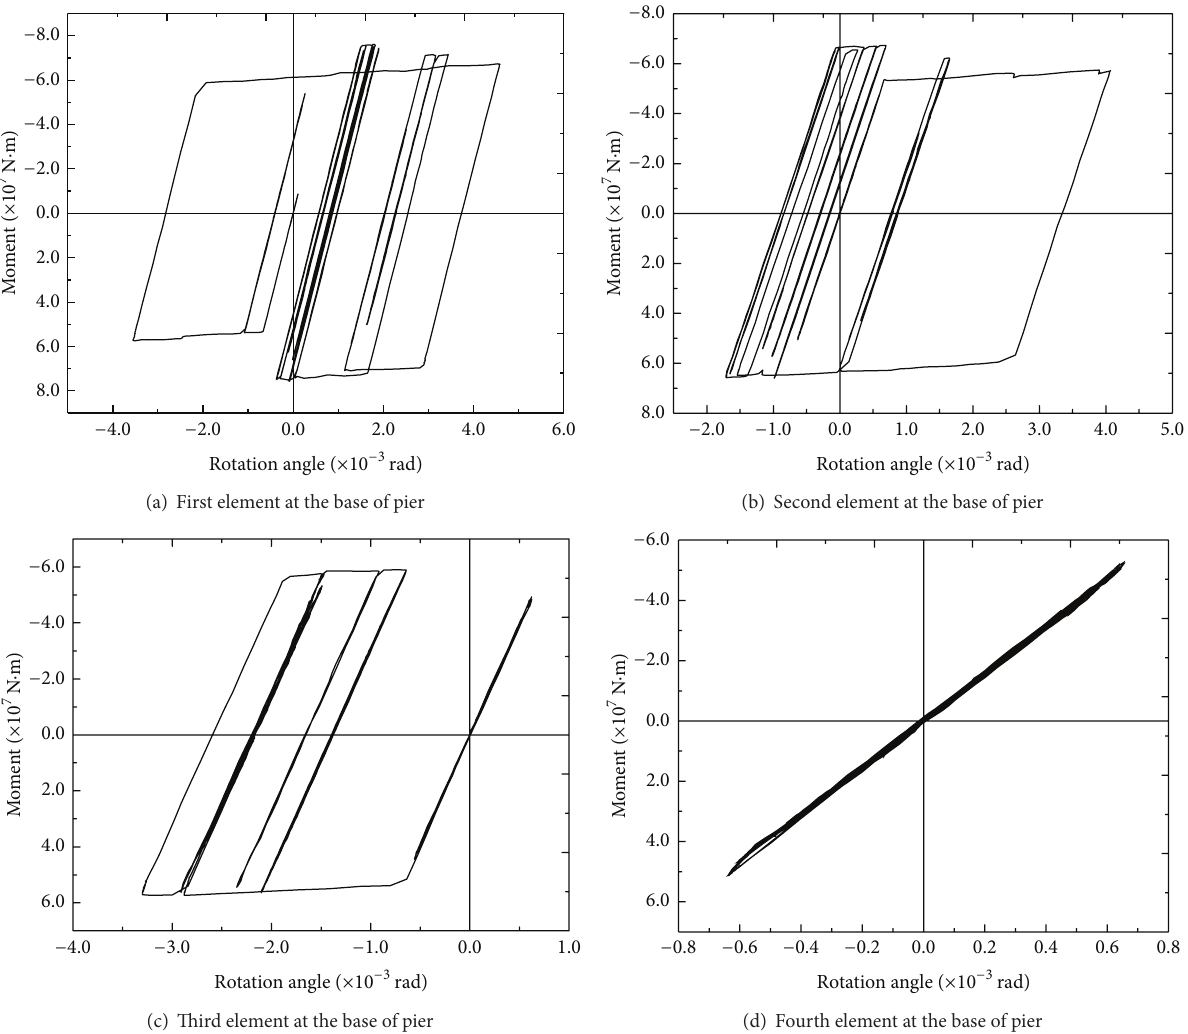
Figure 13: Moment-rotation relationship at the element of pier bottom for lateral near-fault ground motion record of Northridge-Newhall, LA County Fire Station with 350 km/h vehicle speed and 14m